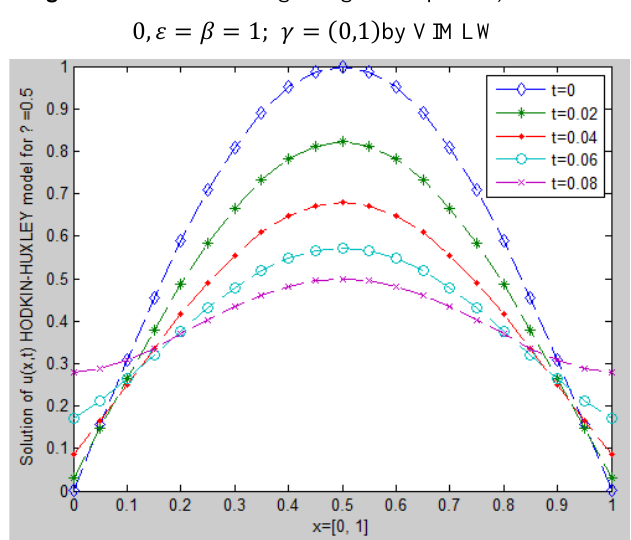
Fig. 8. Solution of Fitzhugh-Nagumo Equation, when 𝛼 = 0, 𝜀 = 𝛽 = 1; 𝛾 = 0.5 by